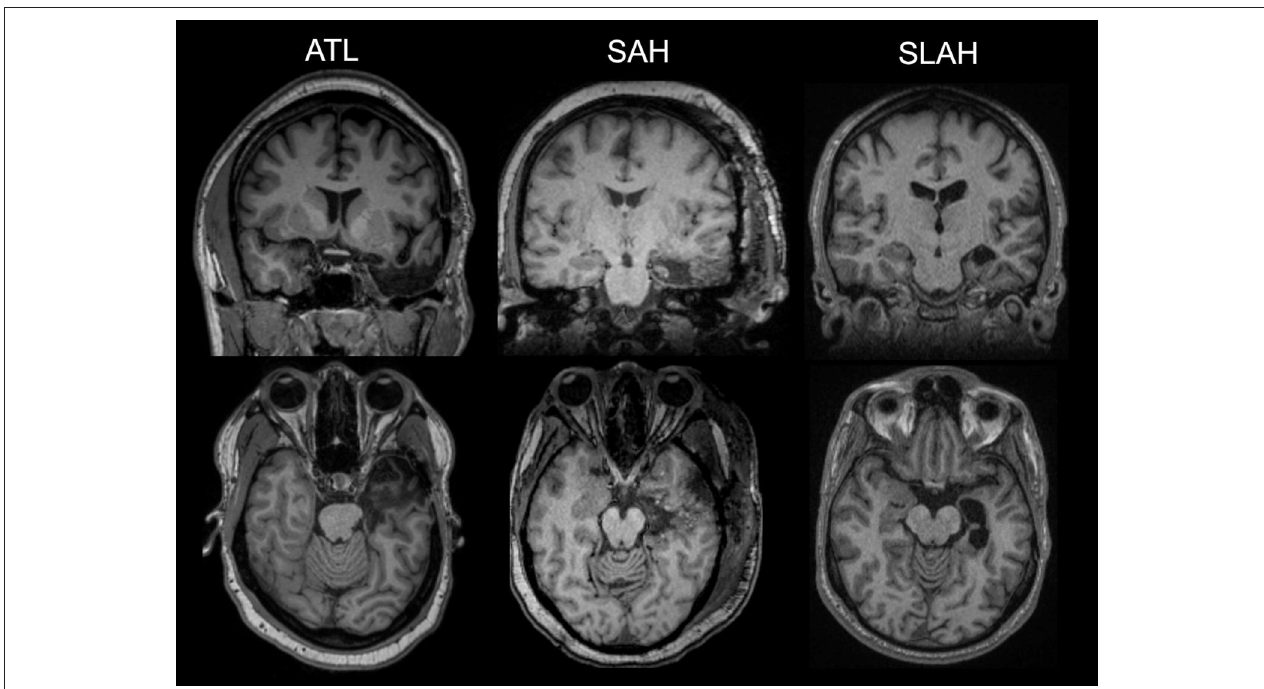
FIGURE 1 | Comparison of selective laser ablation of amygdalohippocampal complex and open resections of the anterior temporal lobe. The first MRI image in each row represents an anterior temporal lobectomy (ATL). The second MRI image is a transcortical selective amygdalohippocampectomy and parahippocampectomy (SAH). The third images on the far right depict a stereotactic laser amygdalohippocampotomy (SLAH), which completely spares the lateral and anterior temporal structures. The MRI images in the top row are from a coronal viewpoint and those in the bottom review are an axial representation. All images are presented using standard neuroradiological convention. (left side of image represents right hemisphere of brain and vice versa). All represent left TL